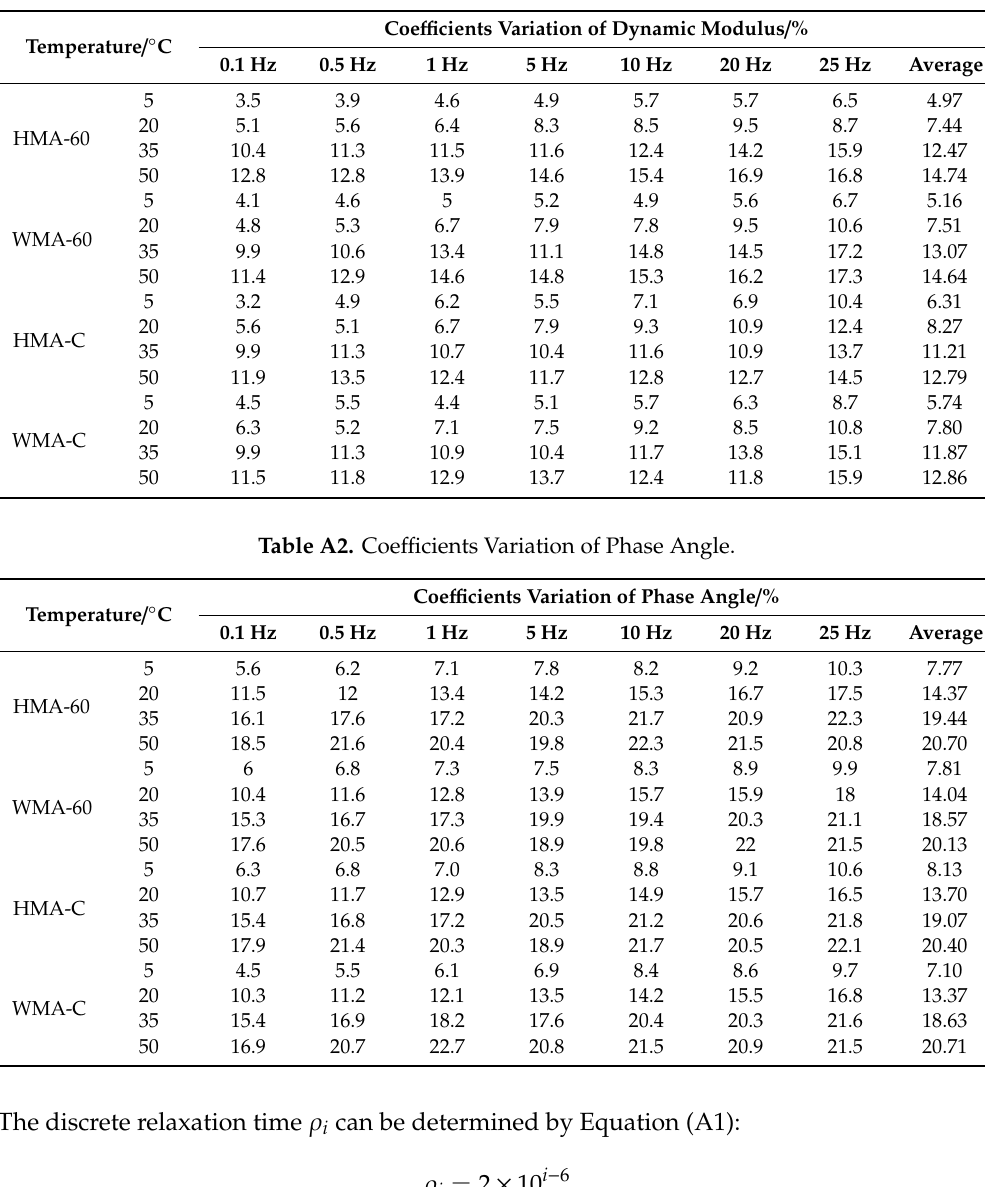
Table A1. Coe ffi cients Variation of Dynamic Modulus.